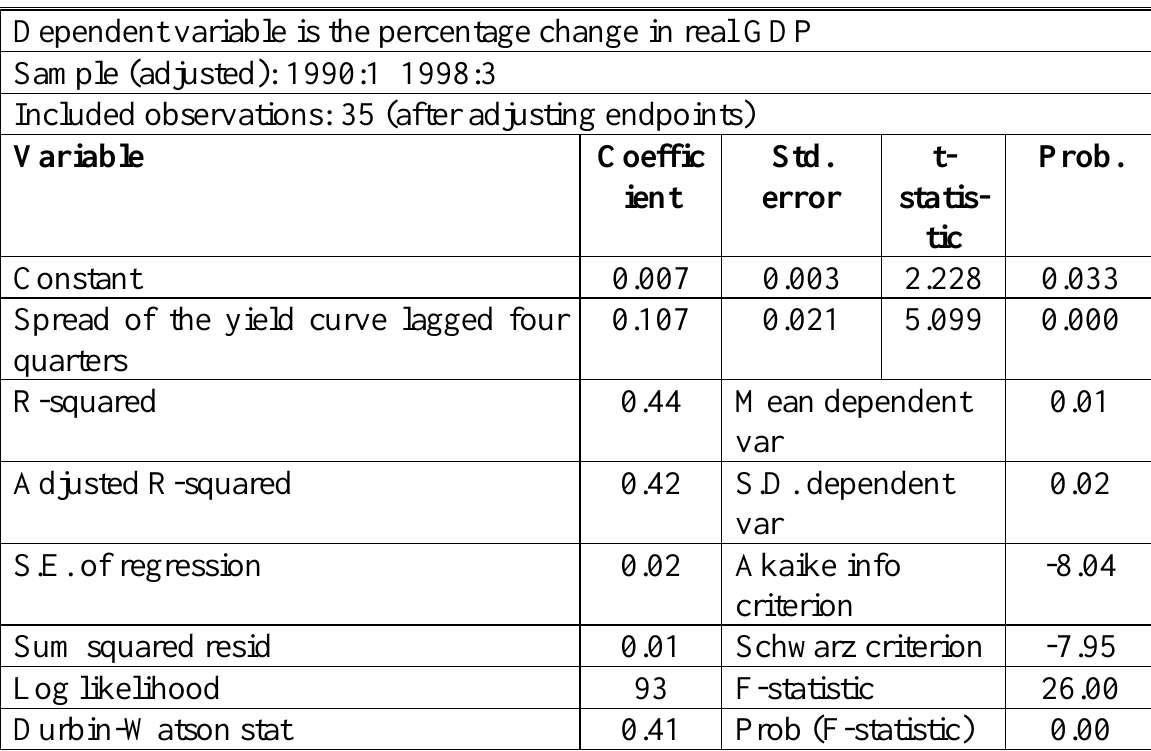
Regression of yield spread on GDP Dependent variable is the percentage change in real GDP Sample (adjusted): 1990:1 1998:3